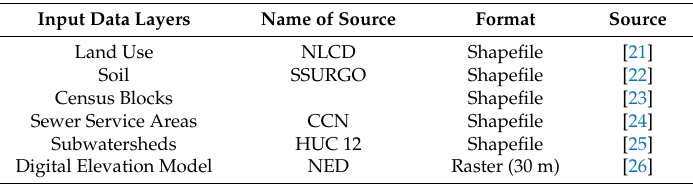
Table 1. Required input spatial data